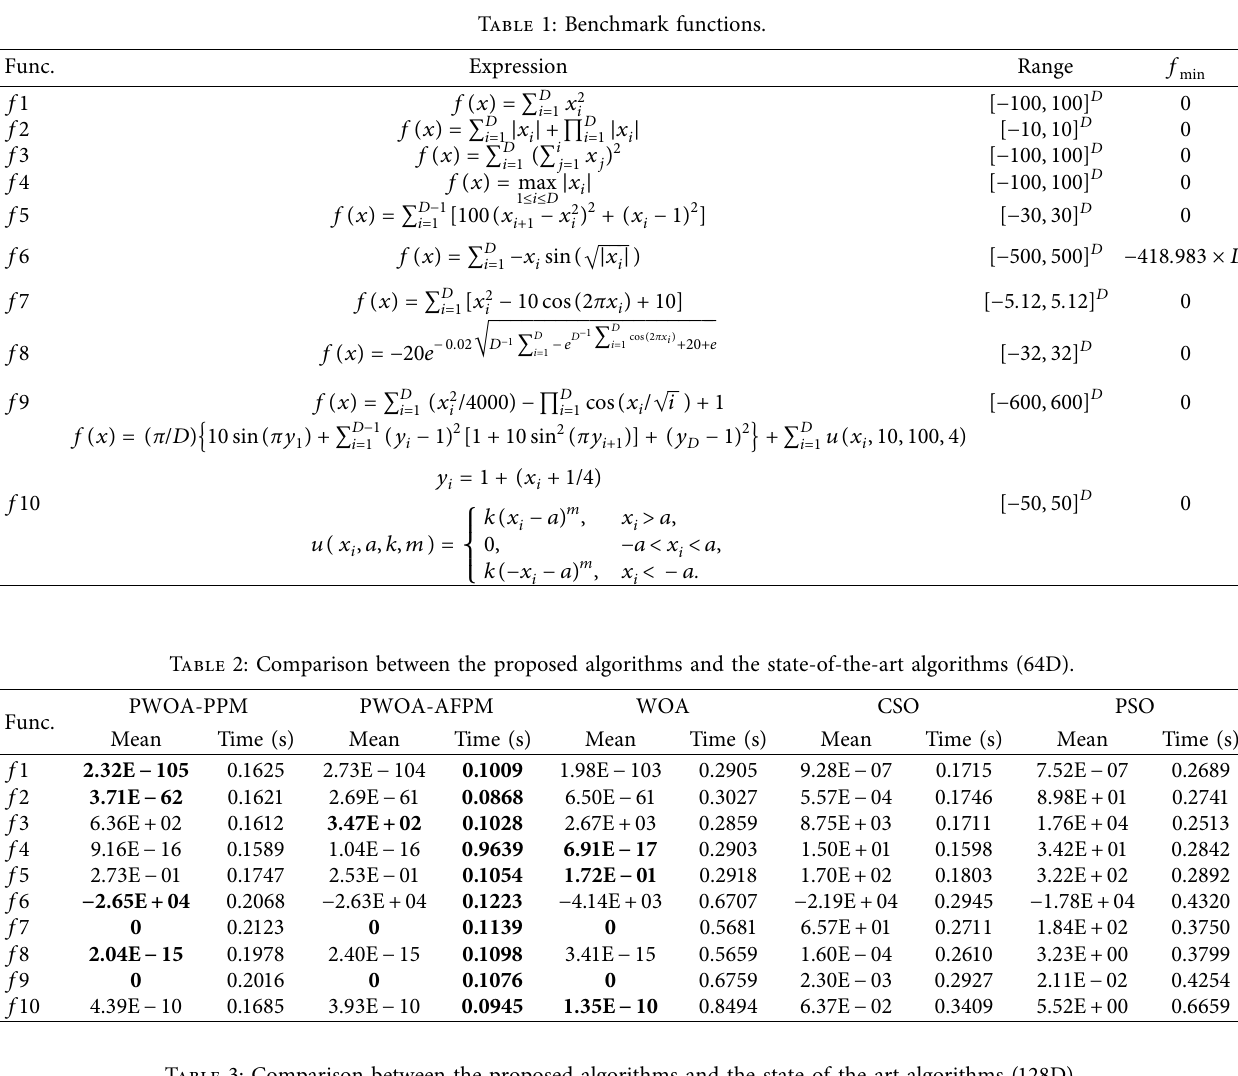
Table 1: Benchmark functions.